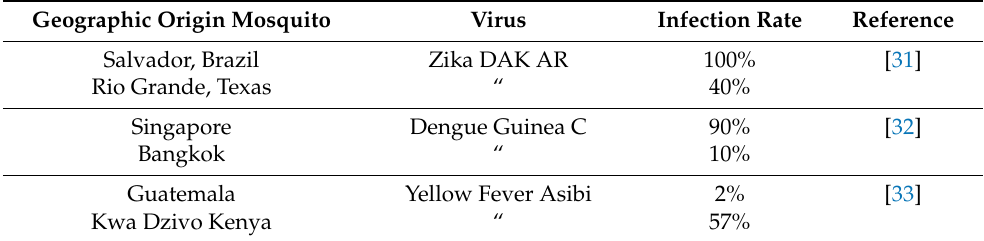
Table 1. Examples of vector competence studies on Aedes aegypti for three of the major viruses this species transmits, Zika, dengue, and yellow fever. The geographic origin of mosquitoes tested is in first column with the virus in the second. Infection rate (third column) is the percent of females that blood fed on infective blood that became